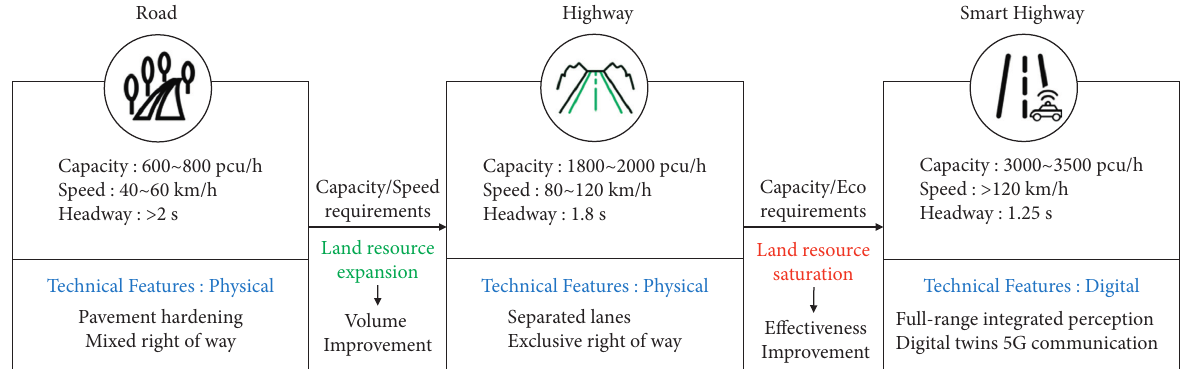
Figure 2: Process of upgrading the technical form of the road transport system.